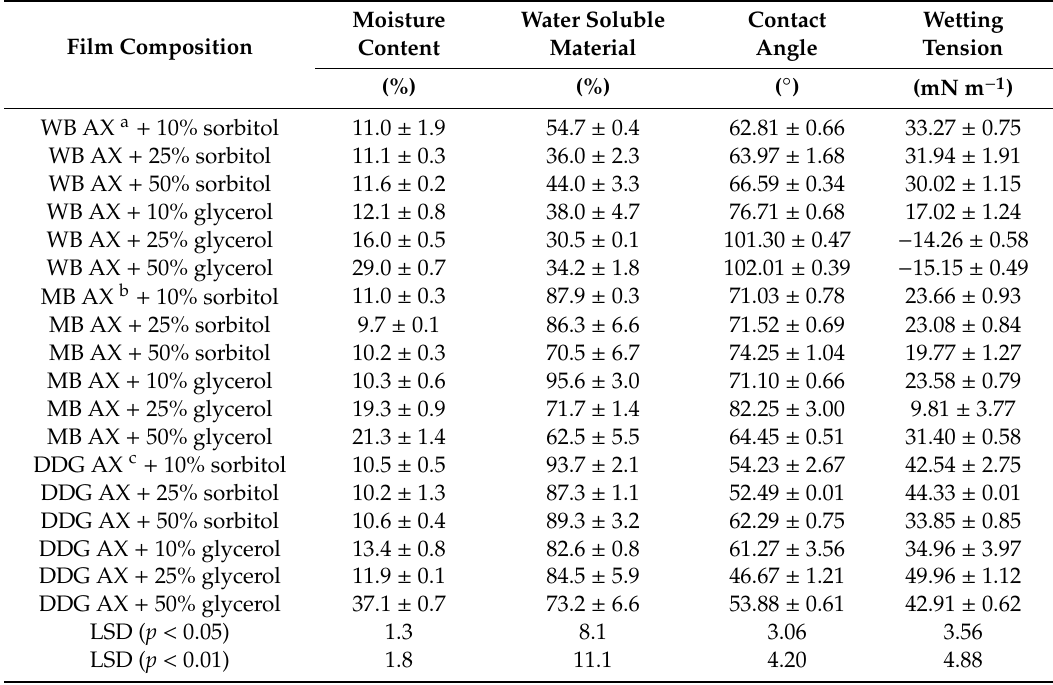
Table 2. Interactions of wheat bran arabinoxylan, maize bran arabinoxylan, and dried distillers grain arabinoxylan films with